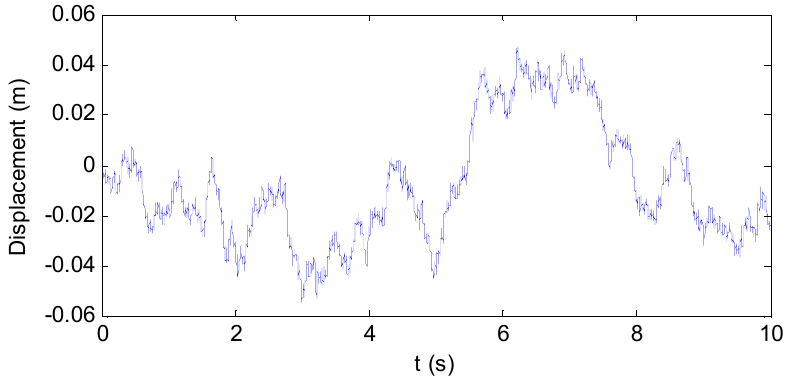
Figure 14. Control process of the semi-active suspension.